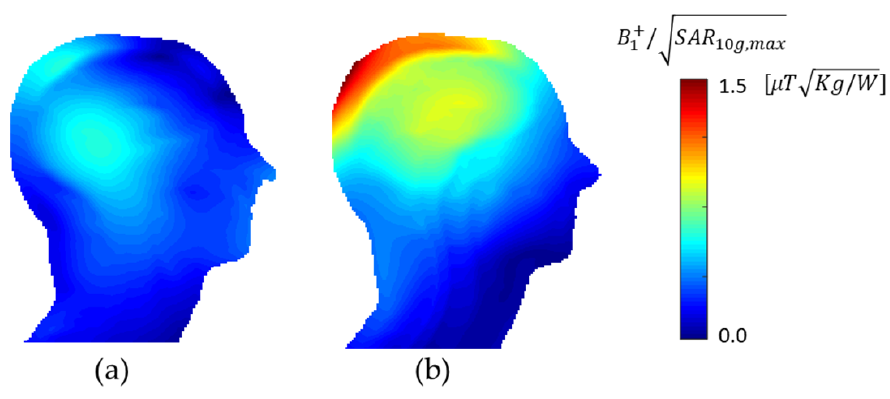
Figure 4. | B + | fields in the sagittal view for ( a ) head BC coil and the ( b ) yurt BC coil. Next, SAR 10g maps were obtained from each coil, as shown in Figure 5. The axial slices in Figure 5 correspond to the maximum SAR from each of the coil. The SAR value of the head coil was higher than yurt coil. The peak SAR values in the head model volume were 0.31 and 0.09 W/Kg for the head BC and yurt coil, respectively. Moreover, the mean SAR values for the head BC and yurt coil were 0.068 and 0.02 W/kg, respectively. The occurrence of the peak SAR value in this area was unsurprising because the coil geometry is narrower at the top ring of the yurt BC coil relative to the other designs.